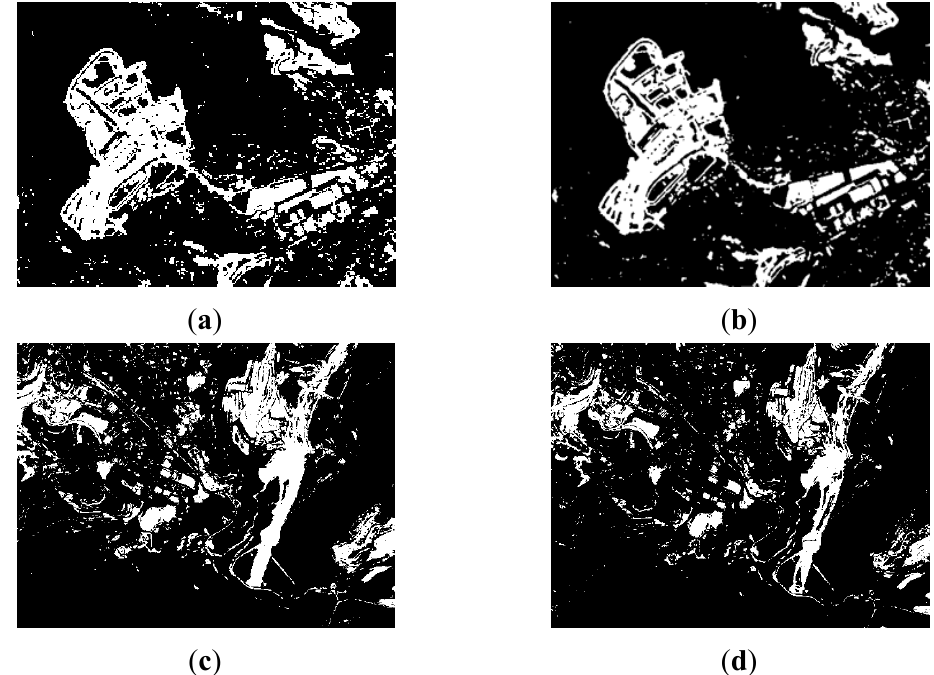
= 0.6, λ = 0.4) ( a ) Summative CVA NDVI